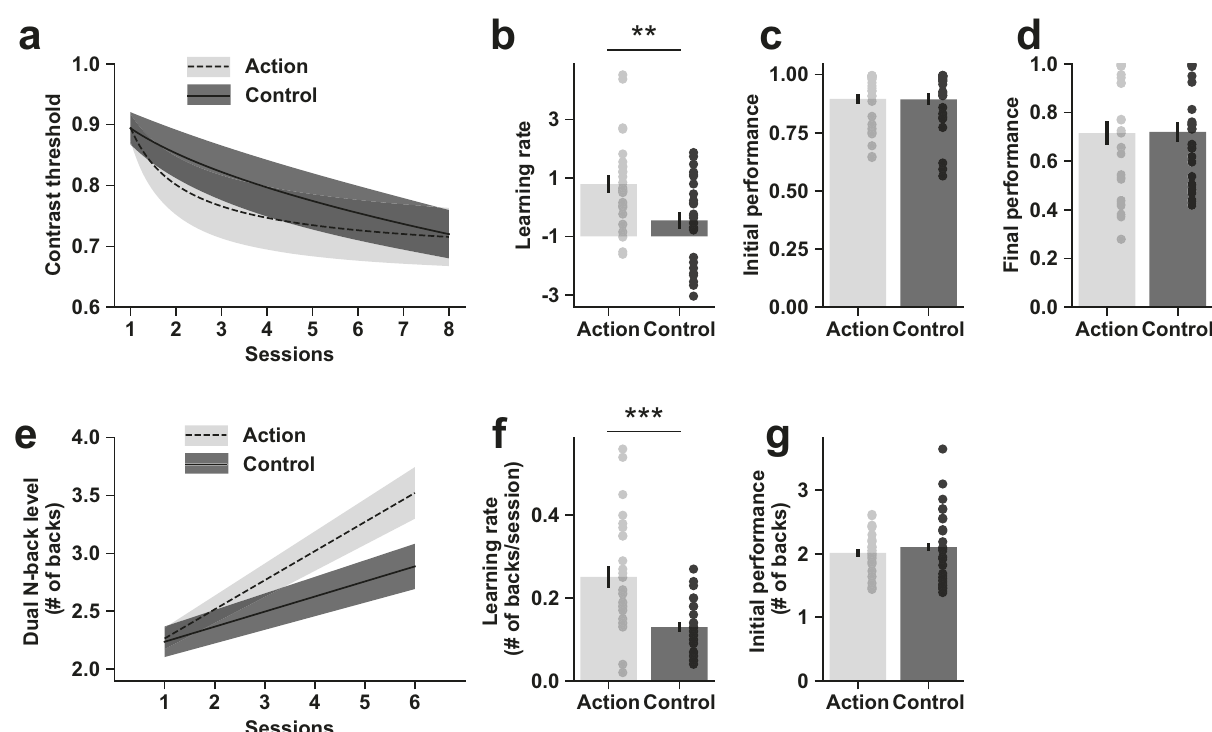
Fig. 3 Enhanced “ learning to learn ” after action video game intervention in the replication intervention study. Similar to Fig. 2, ( a ) shows the impact of video game training on the orientation learning task, while ( e ) shows the impact of video game training on the working memory learning task. In both orientation ( b – d) and working memory learning ( f , g ) tasks, higher learning rates were observed in the action video game group compared with the control video game group ( b , f ). All error bars are S.E.M. across